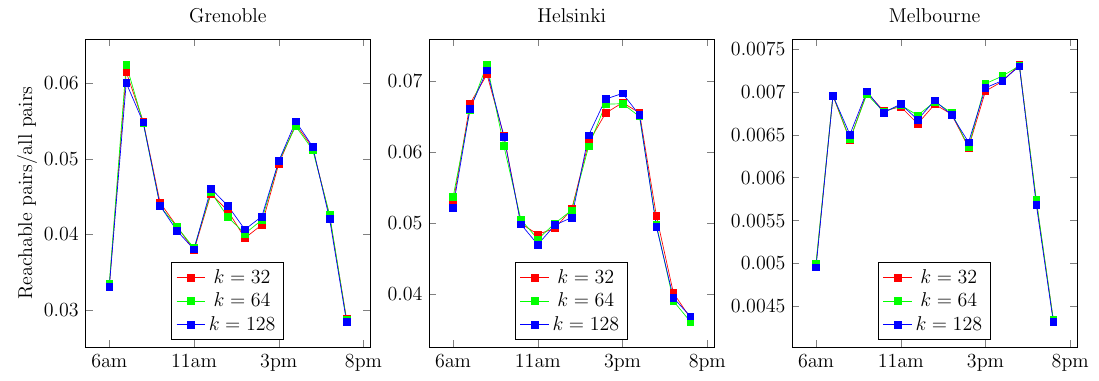
Figure 8. The reachability diagrams of three sample cities with different values of k